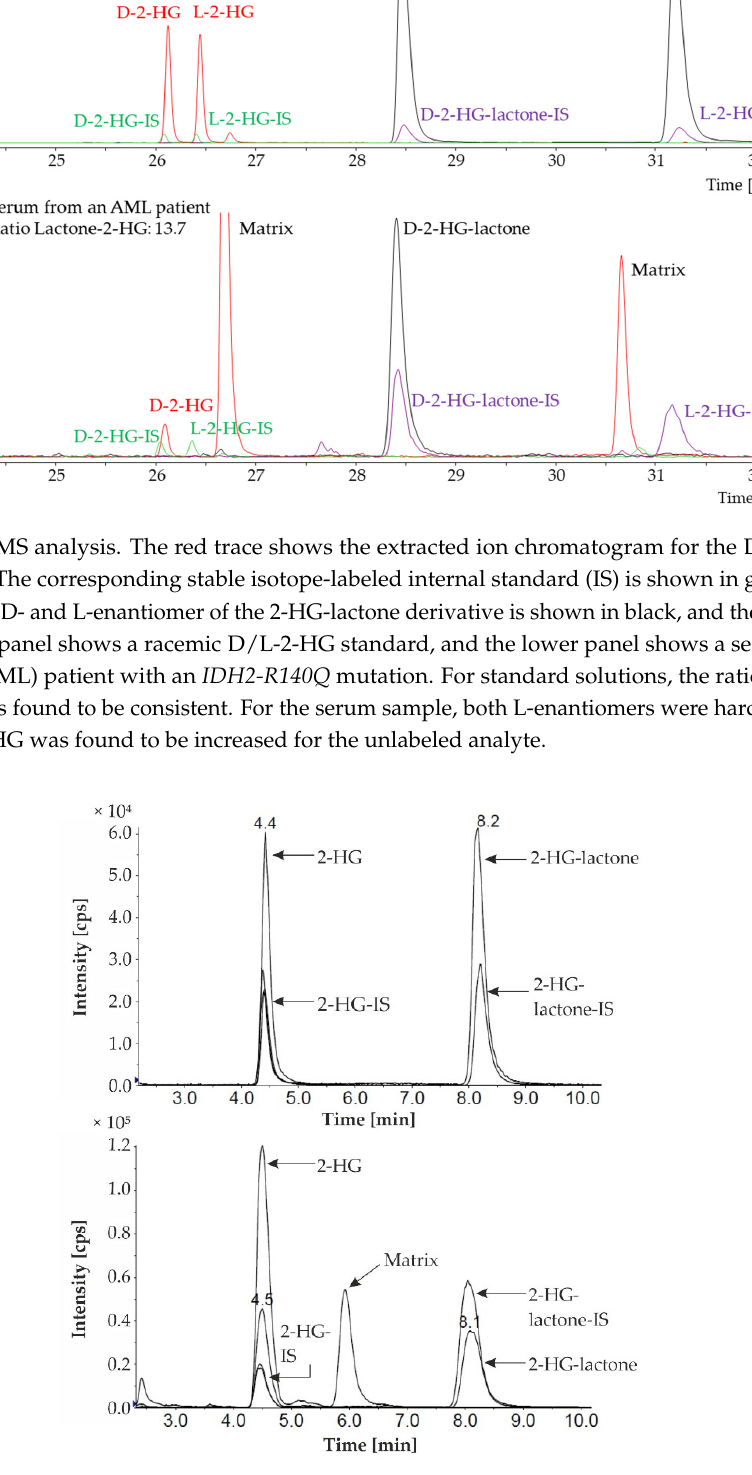
Figure 3. HPLC–MS/MS analysis of a mixture of 2-HG and 2-HG-lactone standard solutions (upper chromatogram) and a serum sample (lower chromatogram) from an AML patient with an IDH(1- R132L) mutation. 2-HG/-lactone marks the traces of the endogenous metabolites, and -IS marks the traces of the stable isotope labeled internal standards (2-HG/-lactone-D 3